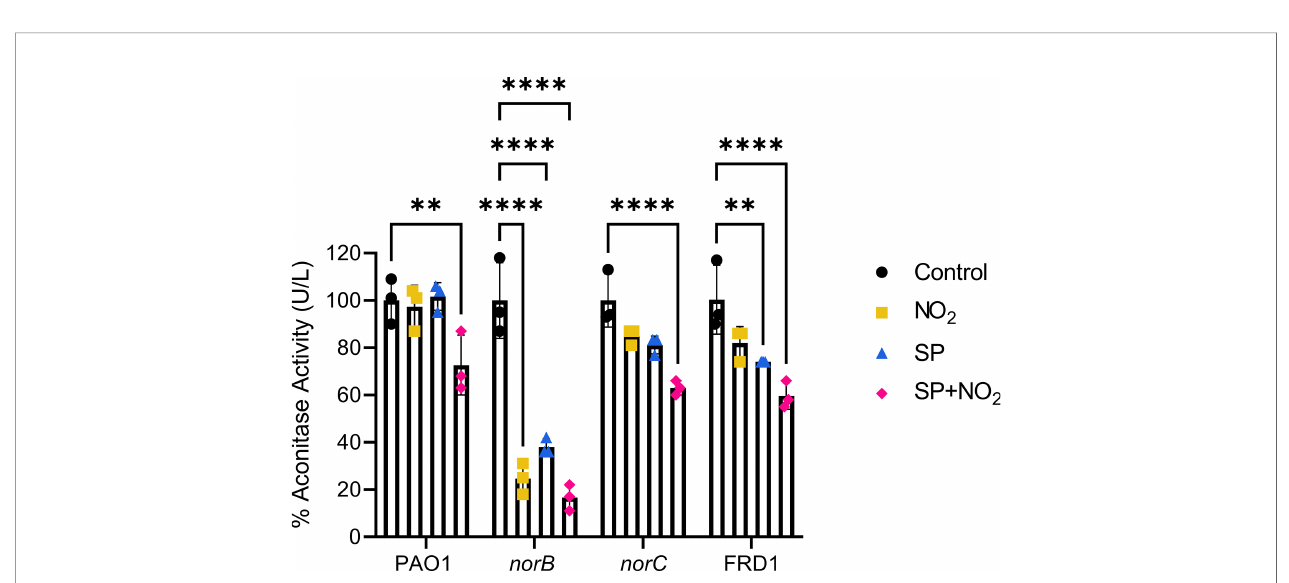
FIGURE 3 | S. parsanguinis and nitrite reduce aconitase activity in the norB mutant. PAO1, norB, norC , and FRD1 were exposed to nitrite, S. parasanguinis , and nitrite and S. parsanguinis . Aconitase activity was measured and normalized to the average of the controls. n=3, error bars represent standard deviation, **P < 0.01, ****P < 0.0001 (Two-Way ANOVA, Tukey Post Hoc Test).